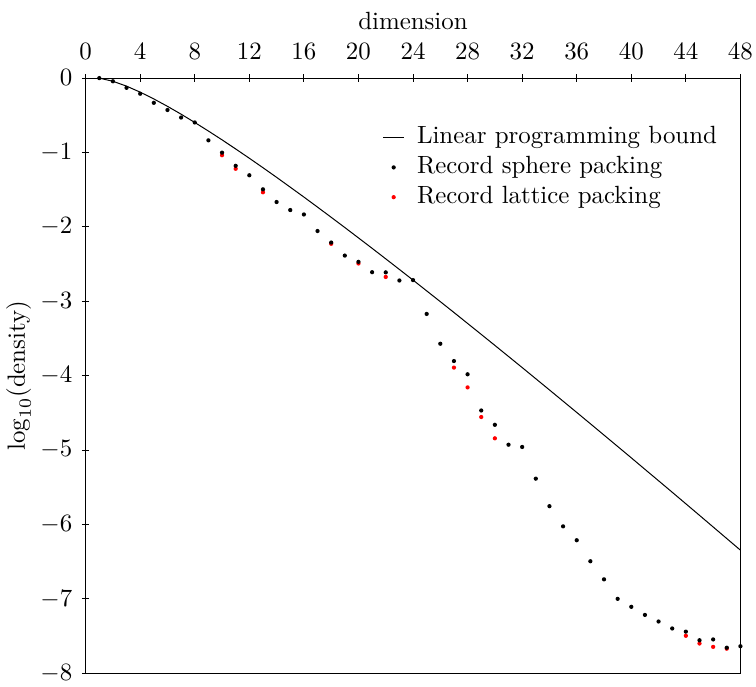
Figure 1 . The linear programming bound for the sphere packing